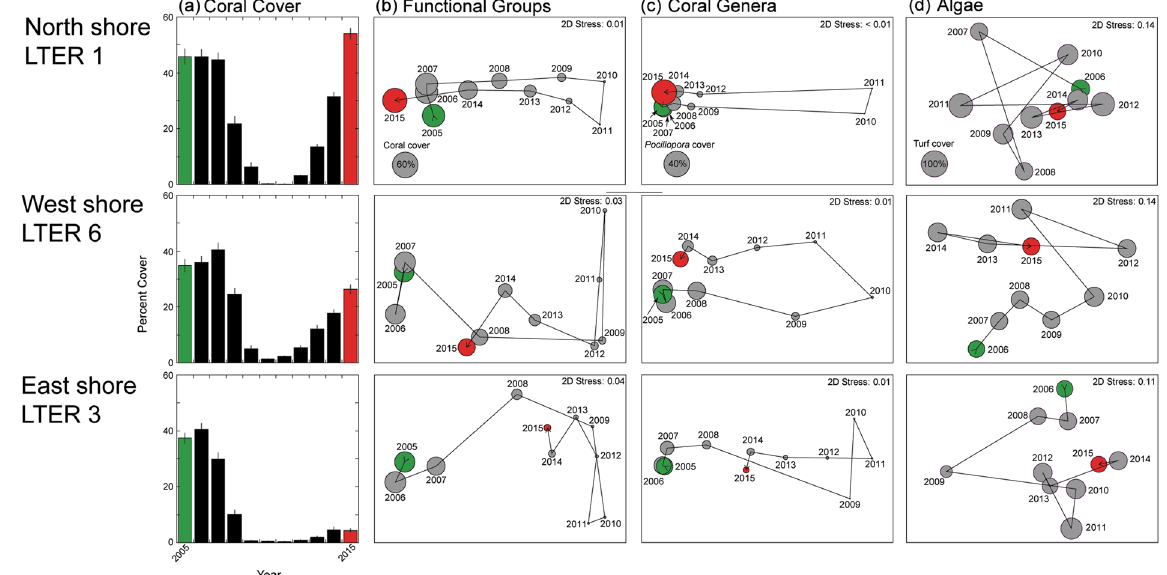
Figure 5. Variation in coral reef community structure between 2005 and 2015, during which corallivory by COTS and Cyclone Oli depressed coral cover close to zero by 2010. Variation in community structure is shown for one site on each side of the island (LTER 1 – north shore, LTER 6 – west shore, and LTER 3 – east shore) to illustrate spatial variation in rate of recovery. ( a ) Mean cover ( ± SE, n = 36–40 quadrats) of scleractinians and Millepora at the three sites. ( b – d ) NMDS plots based on analysis of community structure with ( b ) functional groups ( c ) coral taxa, and ( d ) algal taxa. Circles are scaled to show mean cover in each year of ( b ) scleractinians and Millepora , ( c ) Pocillopora spp. and ( d ) turf algae. Green = first year of analysis and red = last year of analysis.